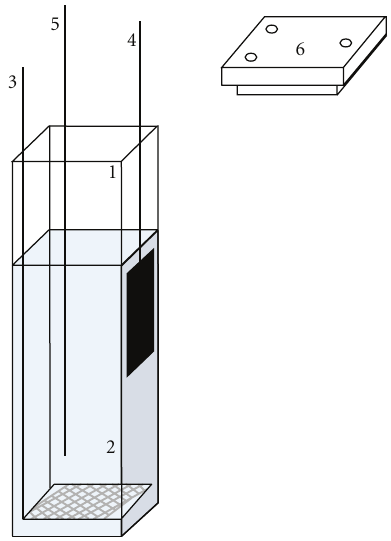
Figure 1: A schematic drawing of the electrolysis cell used for ozone production and in situ measurement showing (1) standard UV cells, (2) 0.1M H 2 SO 4 solution as the electrolyte, (3) modified Ti mesh anode, (4) Pt foil cathode, (5) Ag / AgCl wire reference electrode, and (6) cell cover.